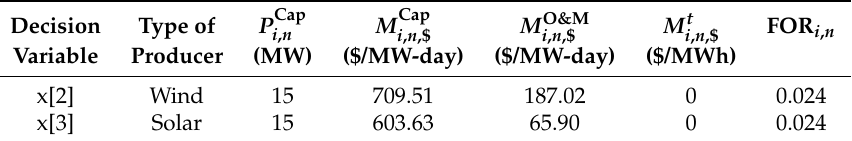
Table 5. Characteristics of the renewable energy technologies for Scenario 3